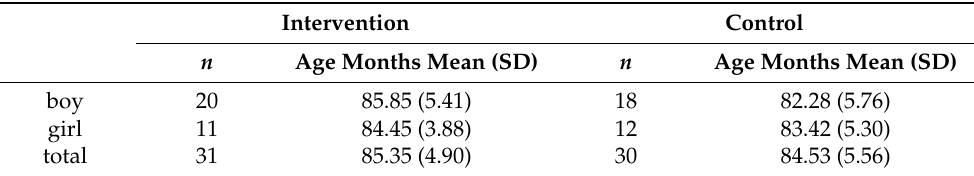
Table A1. Descriptive statistics of the control and intervention group who included at least one of the analyses.